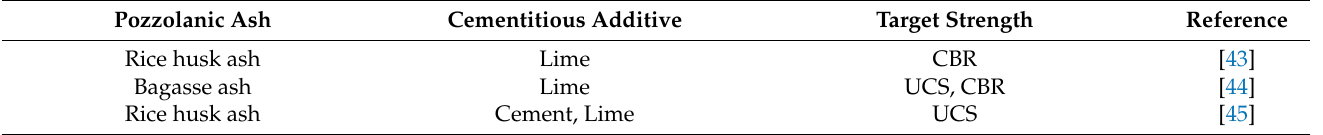
Table 1. Studies on soil stabilisation using agro-based and cementitious additive